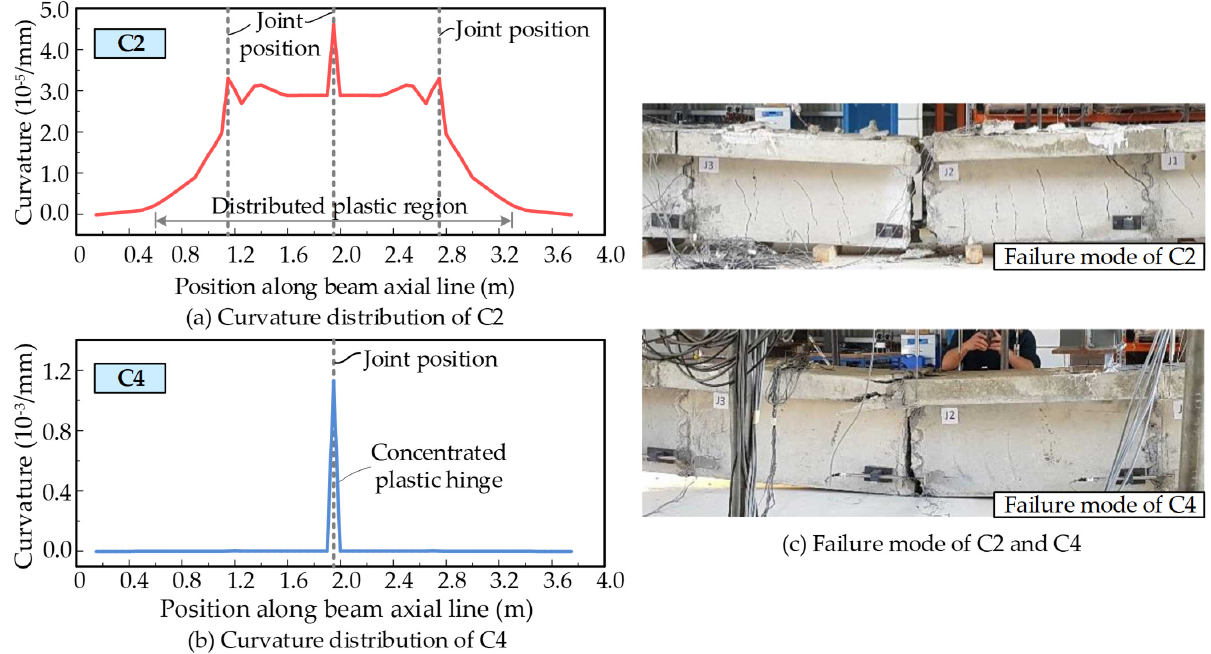
Figure 12. Failure mode comparisons for specimens C2 and C4.